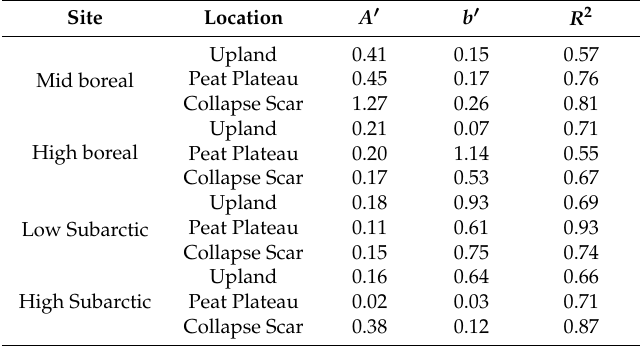
Table 5. Parameter values to estimate the effect of light on surface assimilation (g · CO 2 · m − 2 · h − 1 ) using ecoregions